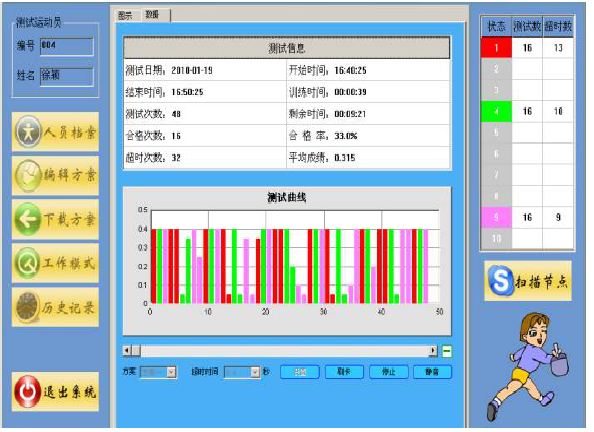
Figure 5. The interface of system